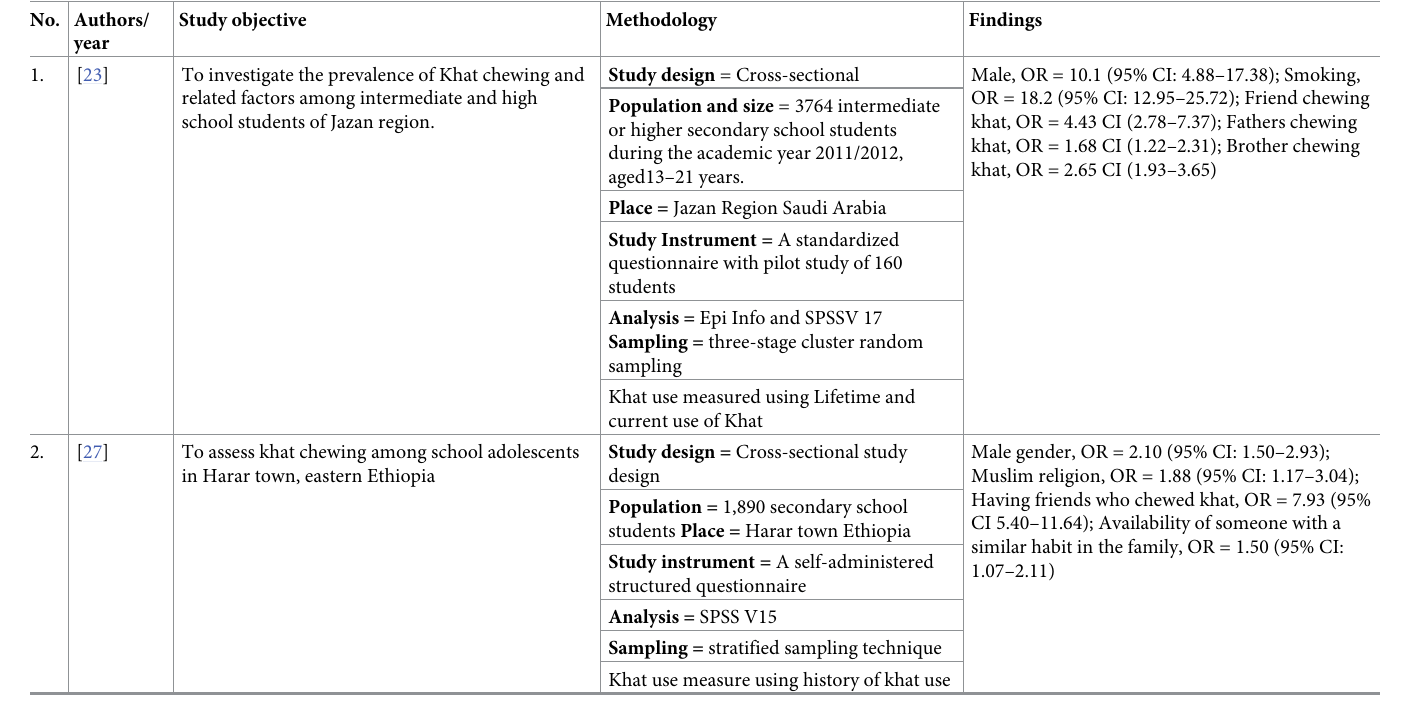
Table 2. Factors associated with Khat chewing among